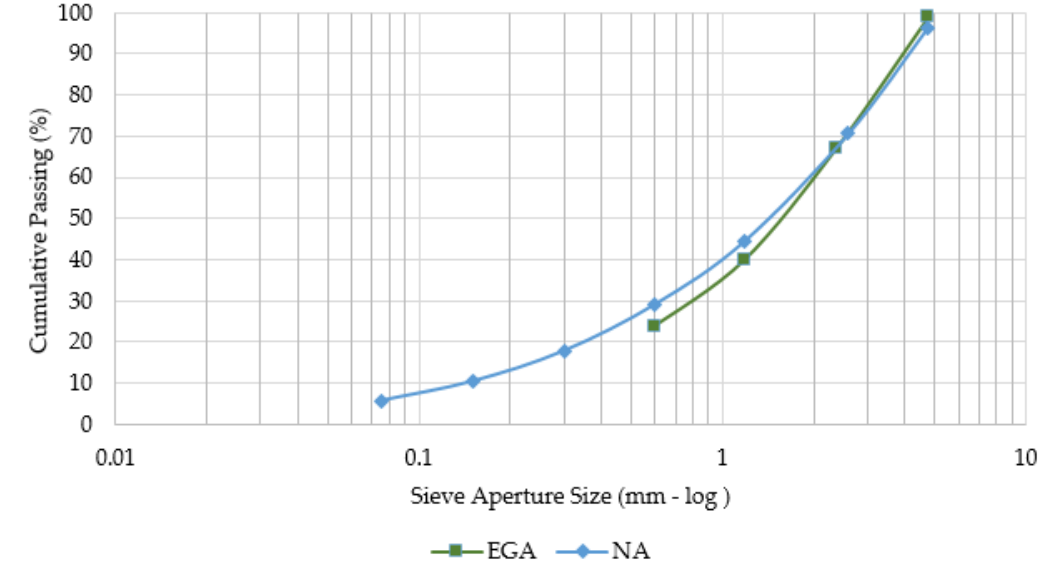
Figure 2. SEM pictures of the utilized EGA.